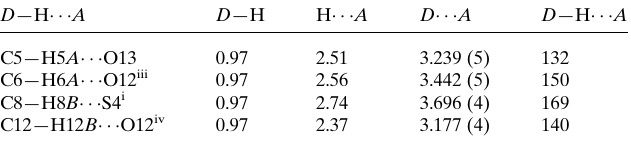
Table 4 Hydrogen-bond geometry (A˚ , (cid:5) ) for II .